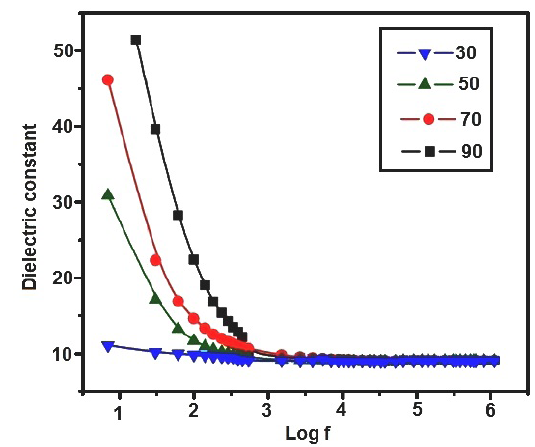
nanoparticles 2